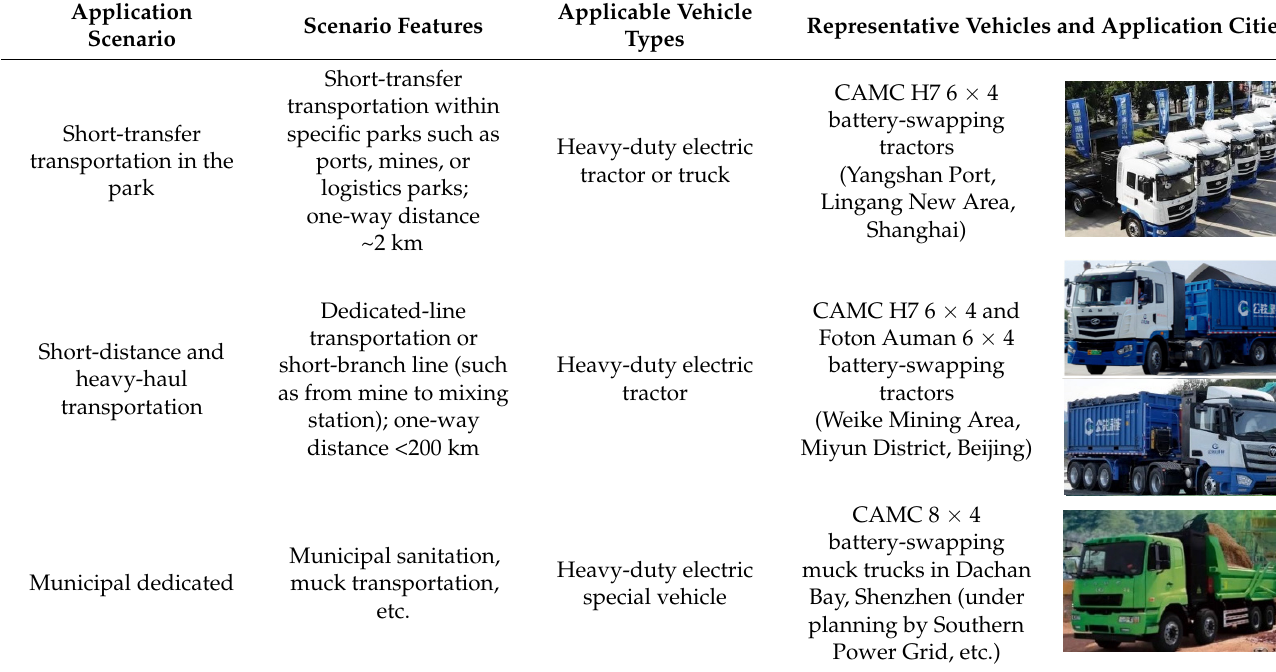
Table 1. Main vehicle types and application scenarios of BS-HDT.